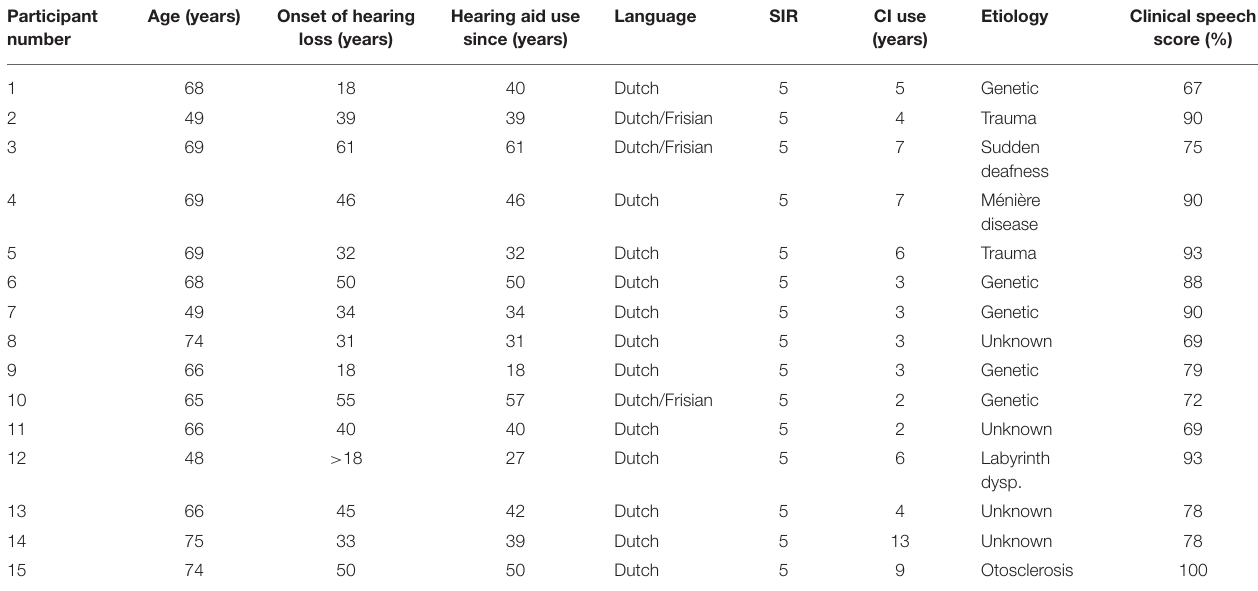
TABLE 2 | Participant details of the postlingually deafened CI users. Participant